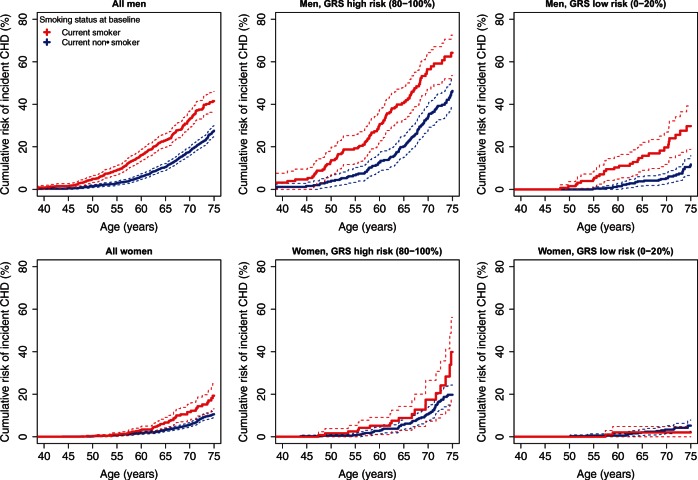
Kaplan-Meier curves for incident CHD event risk
stratified by GRS quintiles and smoking status at baseline, for men and
women in the FINRISK cohorts.